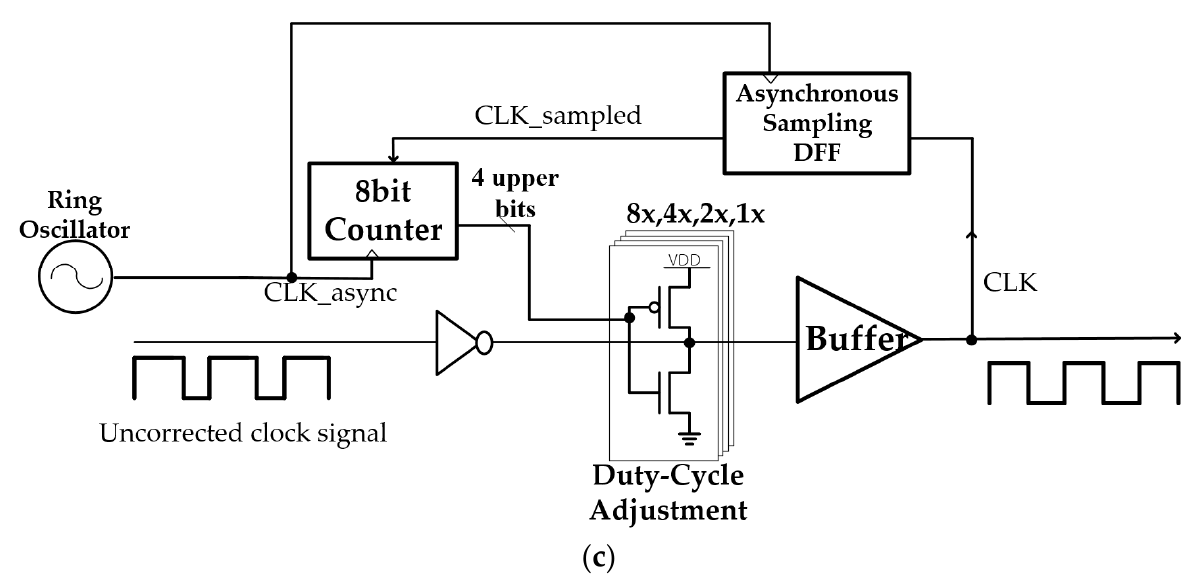
Figure 1. ( a ) Asynchronous sampling scheme using D-flip-flop. ( b ) An example timing diagram of asynchronous sampling, assuming N = 2, α = 0.29. ( c ) Schematic of AS − DCC.